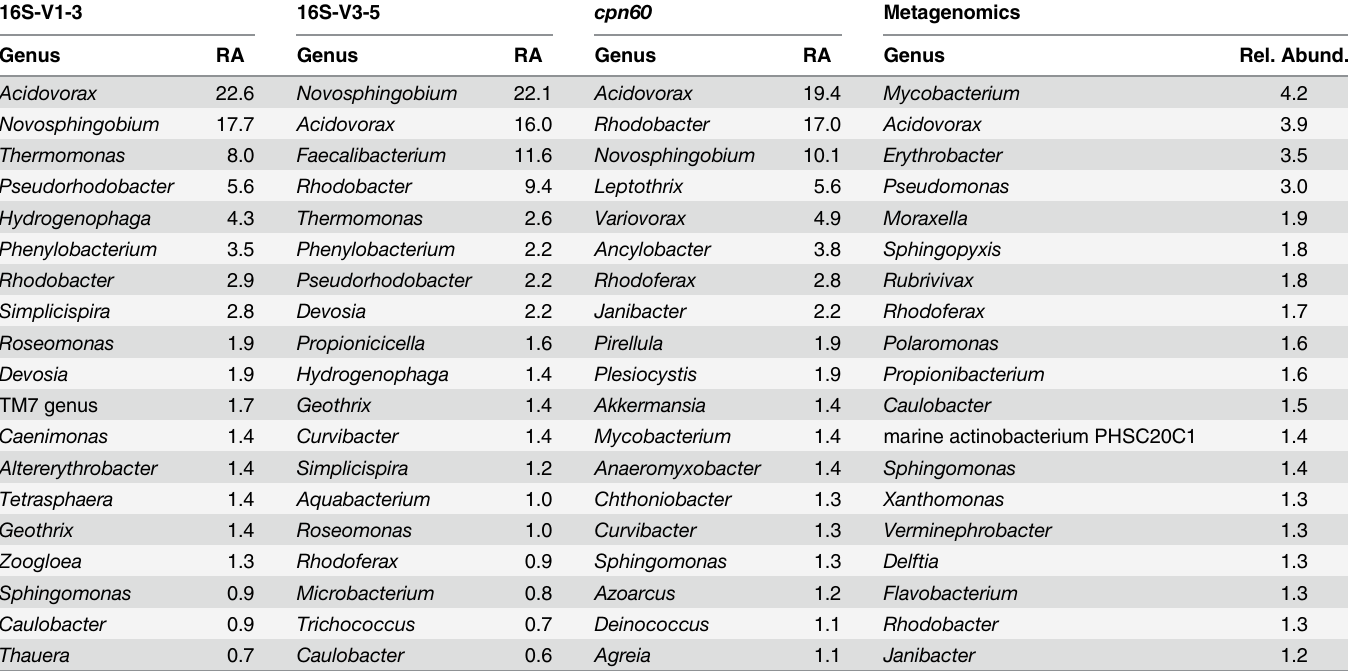
Table 2. Comparison of the 20 most abundant genera determined by different sequencing methods in Plant A biosolids, pre-treatment (August 4,